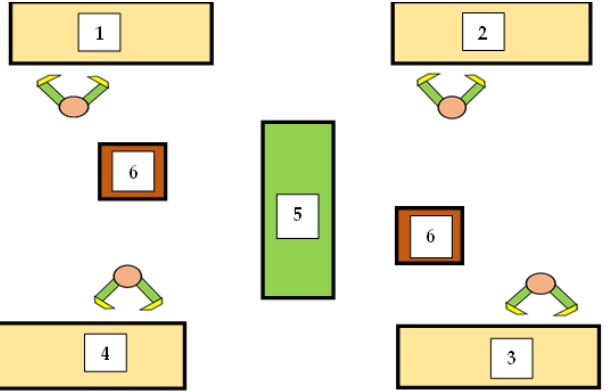
Figure 8. Back-to-back configuration, V10 variant, where: 1, 2, 3, 4—Work modules; 5—Control module; 6—Mobile transport modules to the control